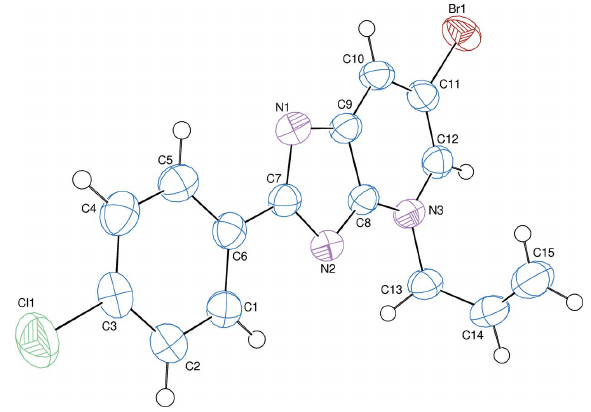
Figure 1 The molecular structure of the title compound, showing the atom- numbering scheme. Displacement ellipsoids are drawn at the 50% probability level.